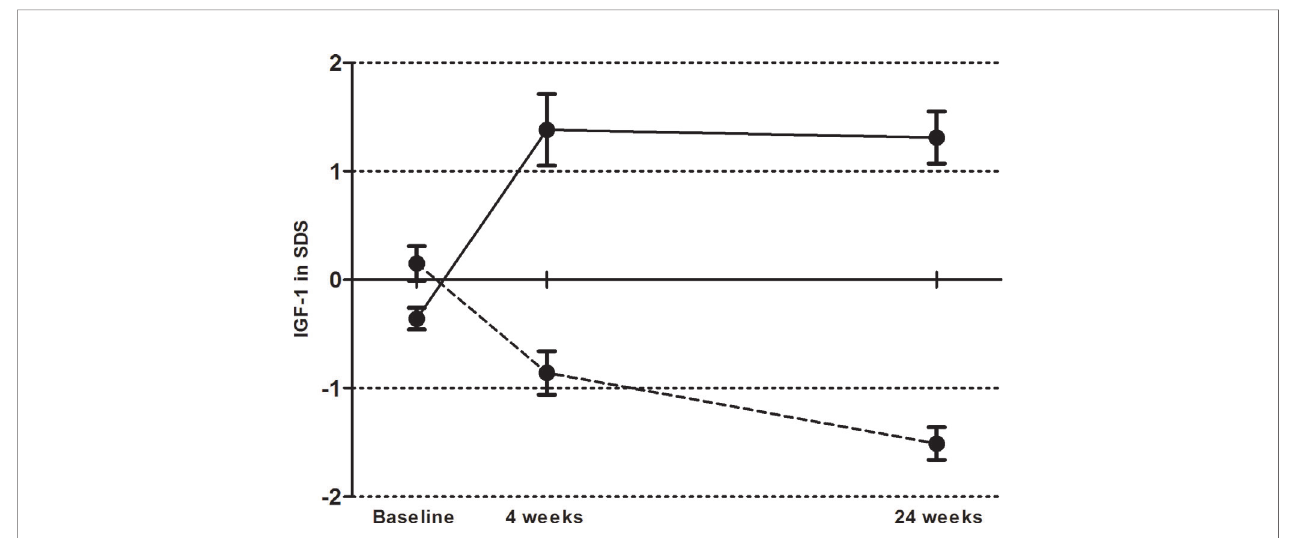
FIGURE 1 | Mean serum total IGF-1 level in SD score (± SEM) at baseline, after four weeks of growth hormone (GH) treatment and at end of follow up in the low dose (dashed line) and high dose (solid line)